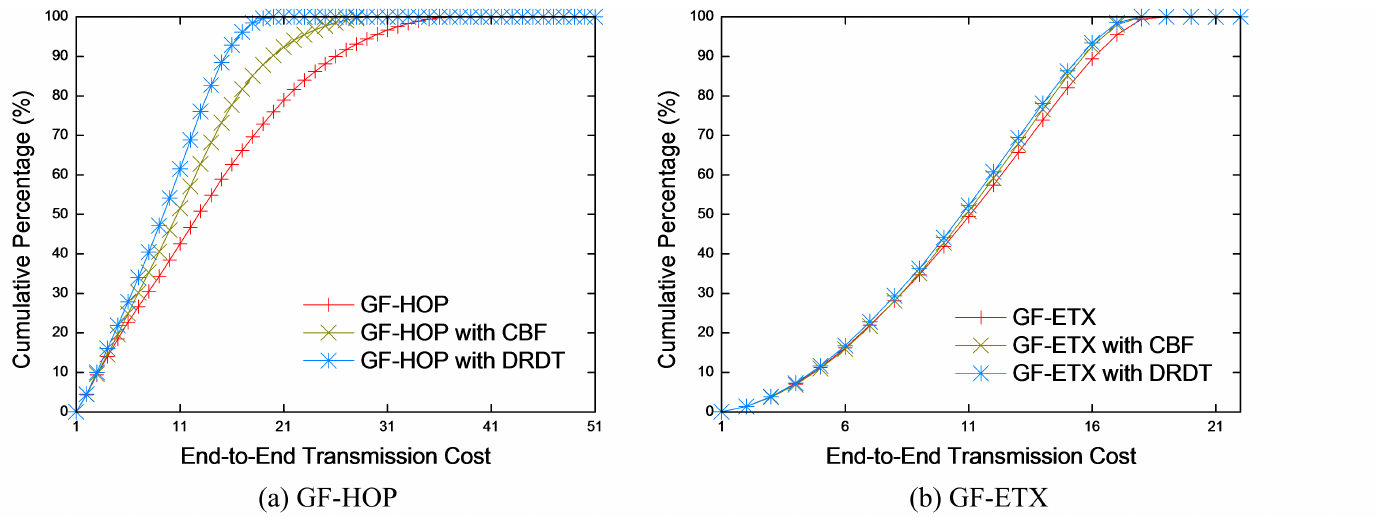
Figure 7. End-to-end transmission